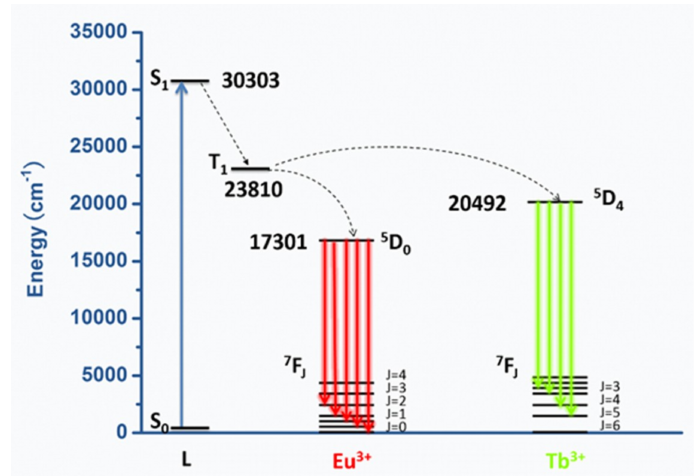
Figure 9. Energy level scheme showing energy transfer processes in complex c.